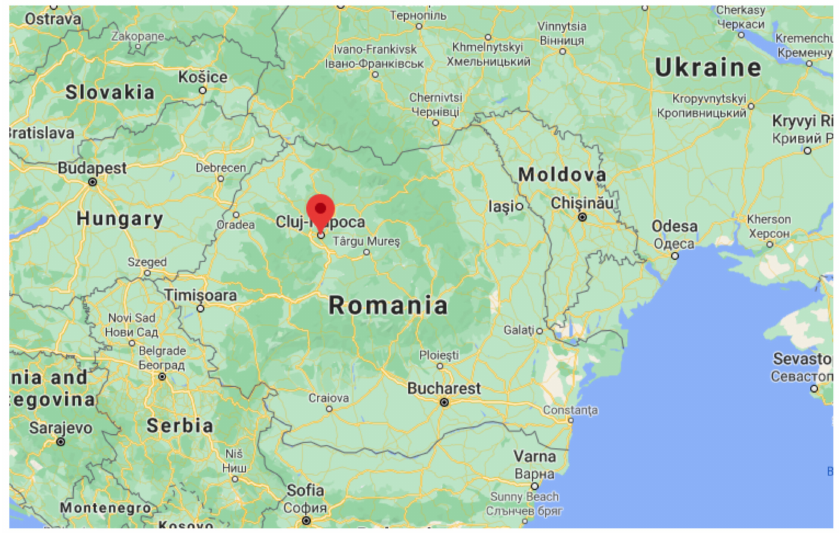
Figure 1. Red aryl of Taxus baccata